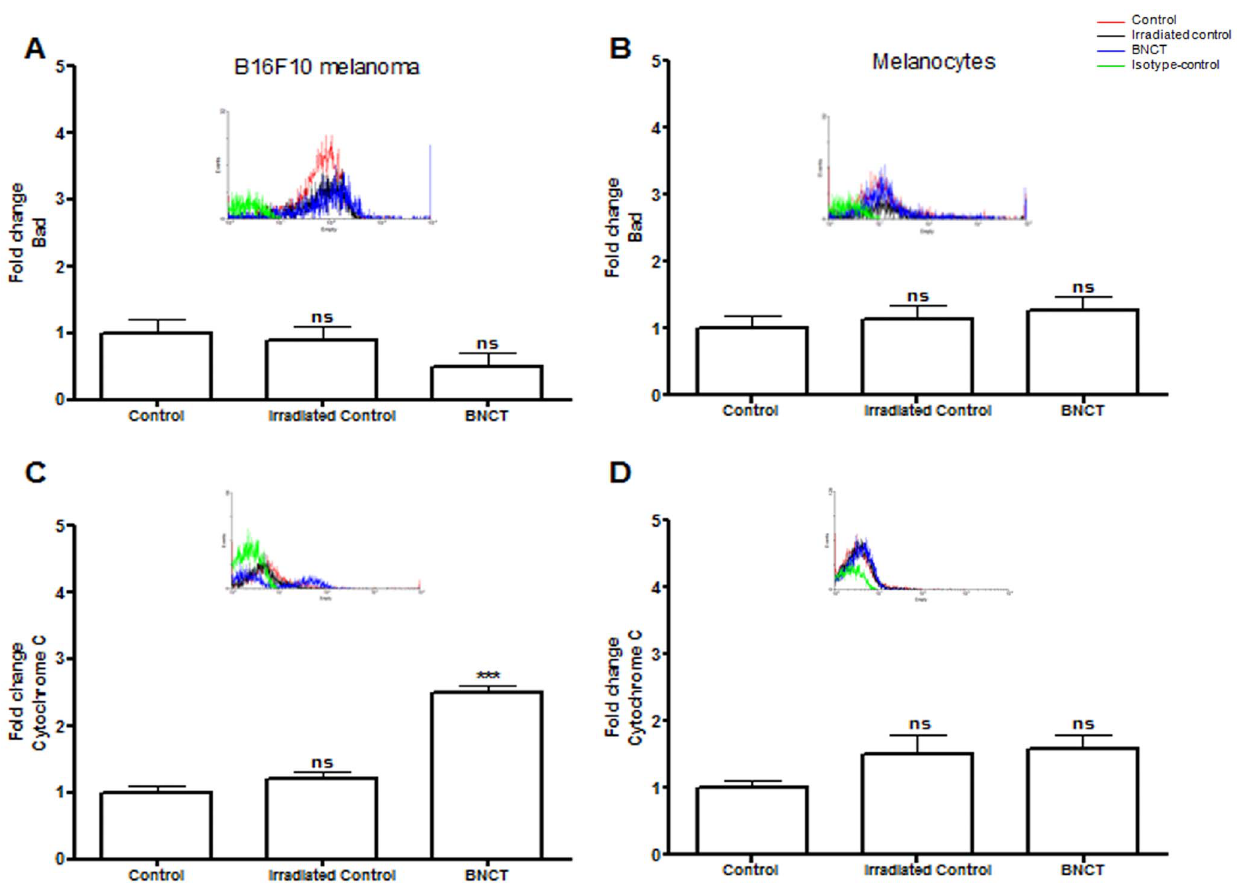
Figure 4. Expression of intrinsic apoptotic markers in B16F10 melanoma cells and normal melanocytes (mean 6 s.d.) measured by flow cytometry. (A) Expression of Bad in B16F10 melanoma cells after BNCT treatment and neutron irradiation alone (irradiated control) compared to cells without any treatment (control). (B)Expression of Bad in normal melanocytes after BNCT treatment and neutron irradiation alone (irradiated control) compared to cells without any treatment (control).(C) Cytochrome c expression in B16F10 melanoma cells after BNCT treatment and neutron irradiation alone (irradiated control) compared to cells without any treatment (control). (D)Expression of cytochrome c in normal melanocytes after BNCT treatment and neutron irradiation alone (irradiated control) compared to cells without any treatment (control). Cells incubated with FITC- conjugated isotype-specific antibodies were used as negative controls. ns: not significant compared to control. *p , 0.05; **p , 0.01; ***p , 0.001 compared to